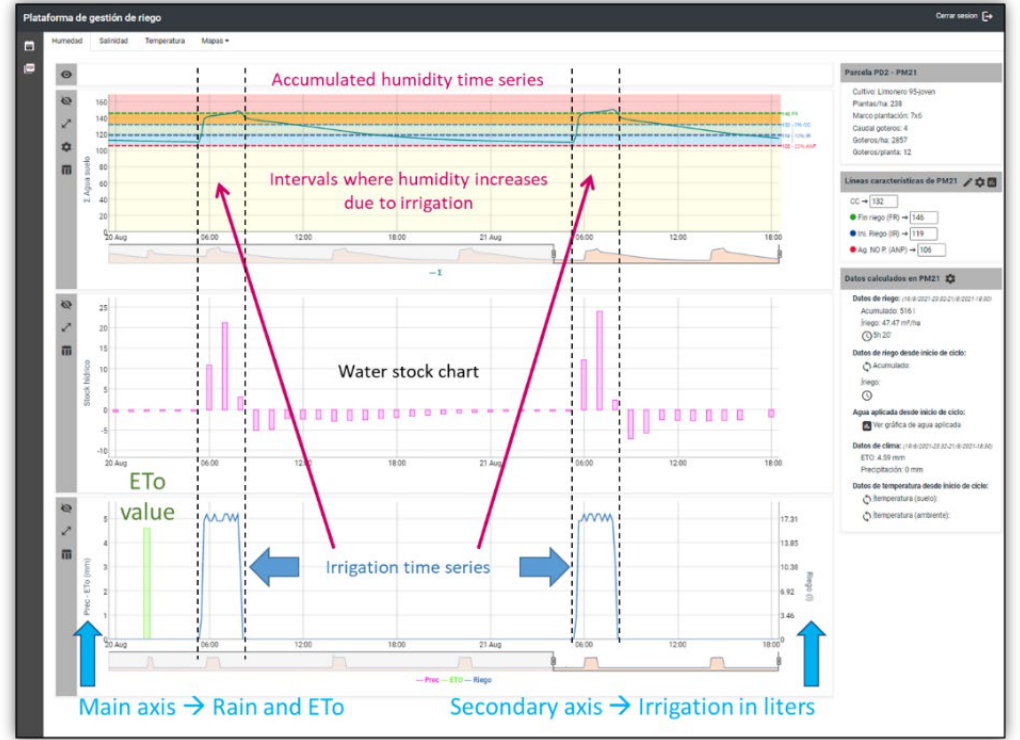
Figure 7. Other valuable charts shown when the Humidity tab is selected. In this case, the ET0 value is not available for 21 August, because the WEB application was accessed in such date. This happens since meteorological data (rain and ET0), specifically, one value per day, are provided by the external service IMIDA SIAM, which updates the information at the end of every day. Rain value is zero; otherwise, it would be represented by a bar such as the ET0 value.